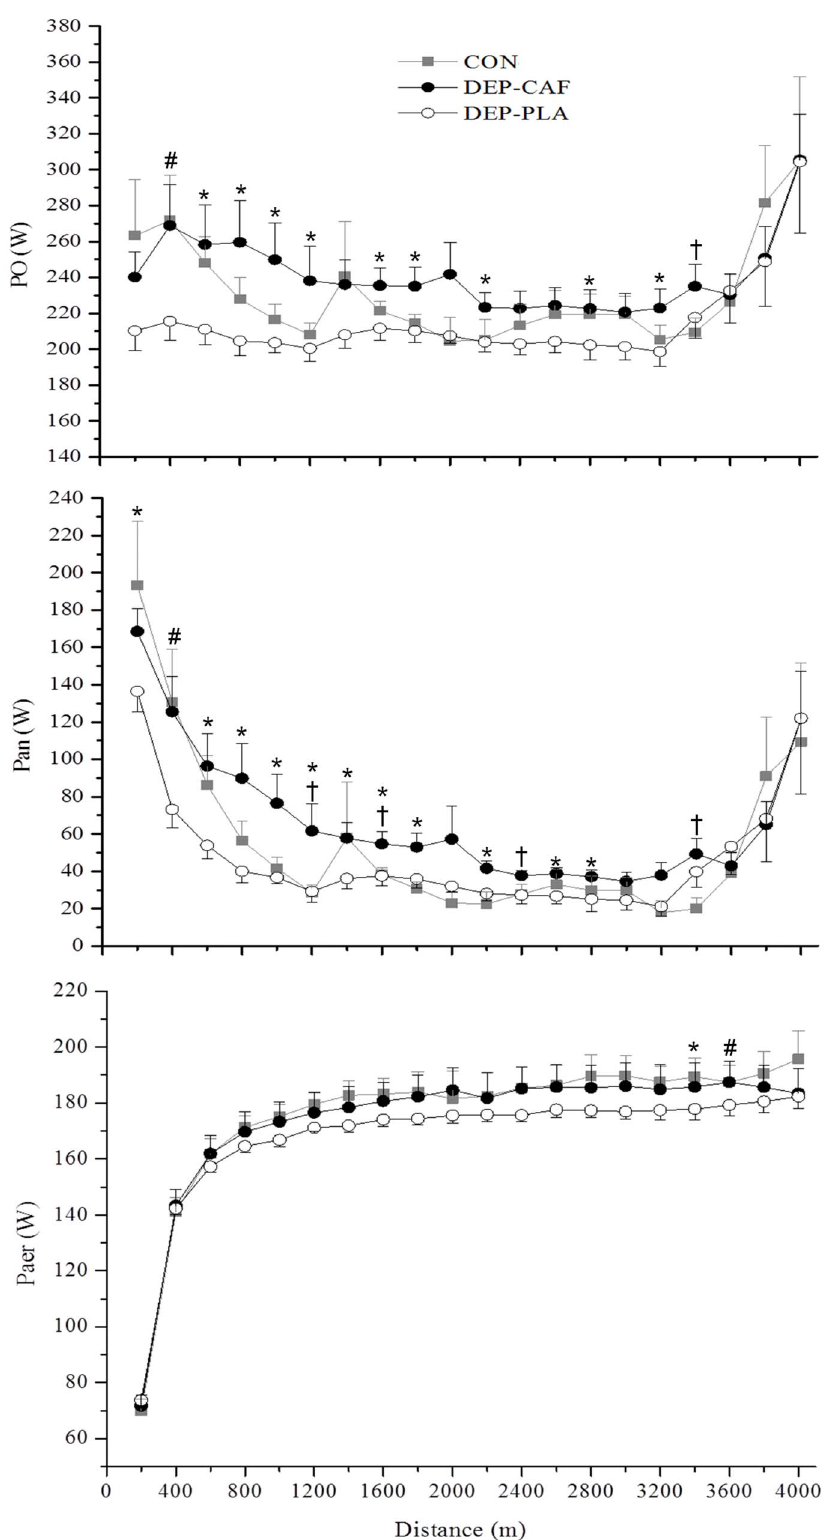
Figure 4. Mean and SD for power output (upper), anaerobic (middle) and aerobic (lower) mechanic power for each 200 m during the 4-km cycling TT for control (CON), low carbohydrate availability with placebo ingestion (DEP-PLA) and low carbohydrate availability with caffeine ingestion (DEP-CAF). *Significantly different between DEP-CAF and DEP-PLA (P , 0.05); # Significantly different between CON and DEP-PLA (P , 0.05); { Significantly different between DEP-CAF and CON (P , 0.05).